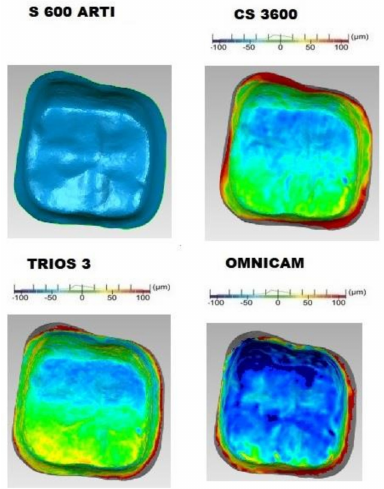
Figure 10. Comparison of the complete preparation in OVA rendering S600ARTI and 3D comparison analysis for IOS with saliva in relation to sample 2. Nominal histogram settings ± 25 microns and critical ± 100